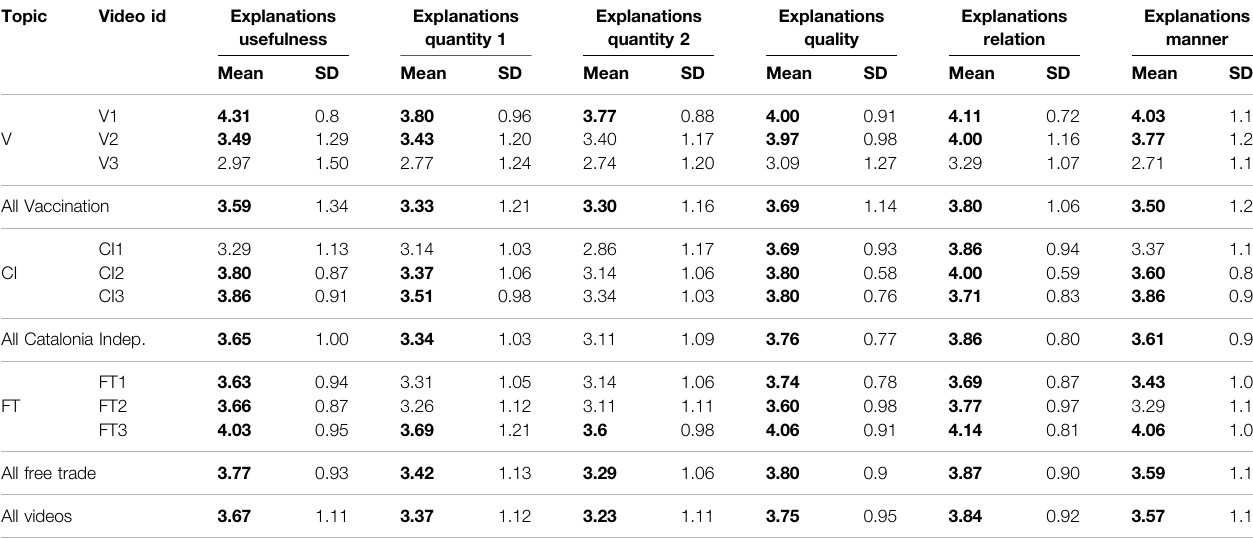
TABLE 6 | Mean and SD for variables explanations usefulness, explanations quantity 1 - enough information, explanations quantity 2 - too much information, explanations quality, explanations relation and explanations manner in the condition w/explanations. Topic Video